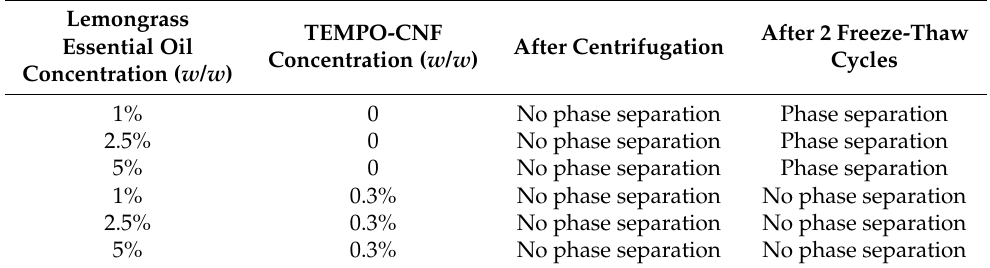
Table 4. Phase behavior of emulsions stabilized by Tween 80 (Oil/Tween 80 ratio 1:3) with or without the presence of TEMPO-CNF against centrifugation and freeze-thaw cycle